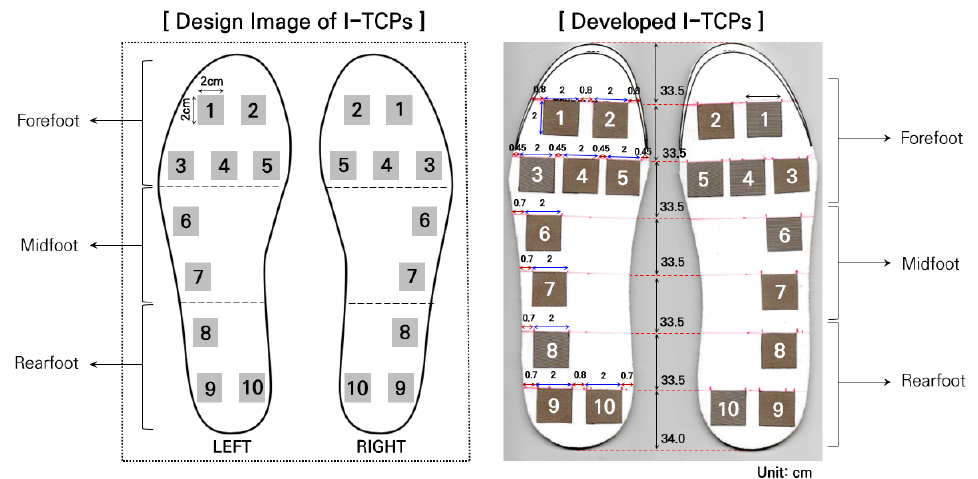
Figure 1. Design of insole-type textile capacitive sensors (I-TCPs).